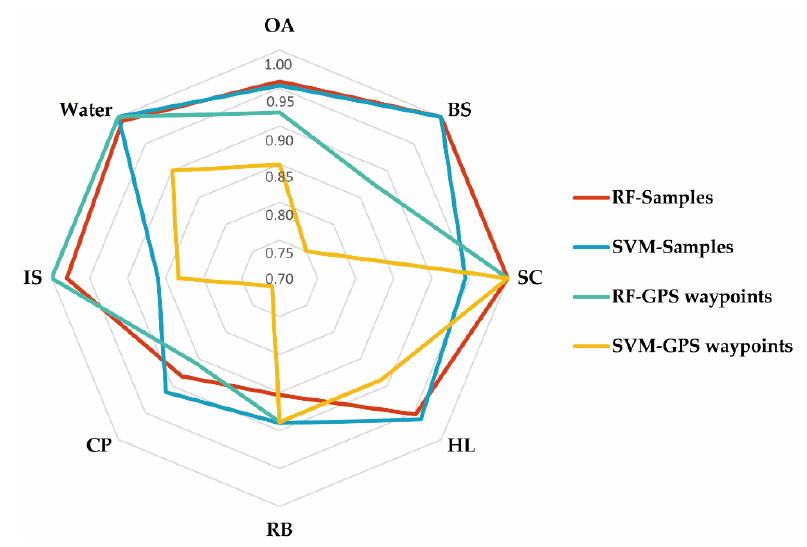
Figure 6. Comparison of classification accuracy for different mangrove cover.